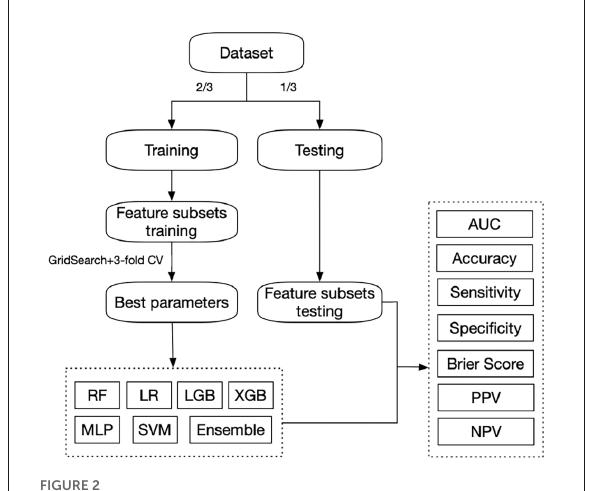
FIGURE2 Schematic diagram of our prediction